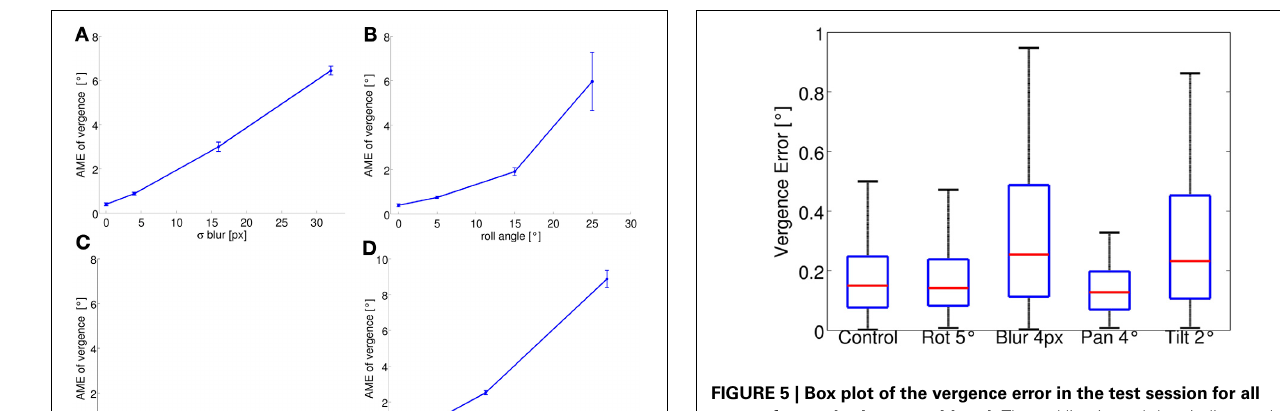
FIGURE 5 | Box plot of the vergence error in the test session for all types of perturbations considered. The red line in each box indicates the median; edges of a box are the 25th ( q 1 ) and 75th ( q 3 ) percentiles. The whiskers extend to values up to q 3 + 1 . 5 ( q 3 − q 1 ) . The plotted range extends up to approximately ± 2 . 7 σ (standard deviation) of the data. Values outside this range are considered outliers and are not plotted.